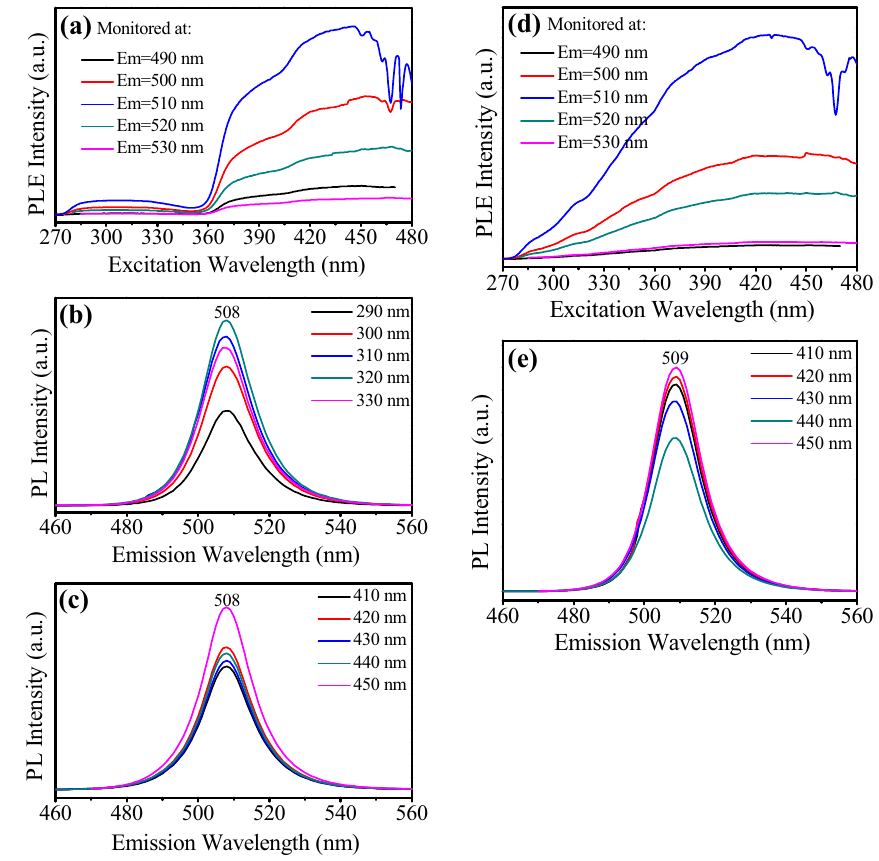
Fig. 4 a PLE spectra of CsPbBr nanocrystals moni- 3 tored at different wavelengths around 510 nm. b PL spectra of CsPbBr